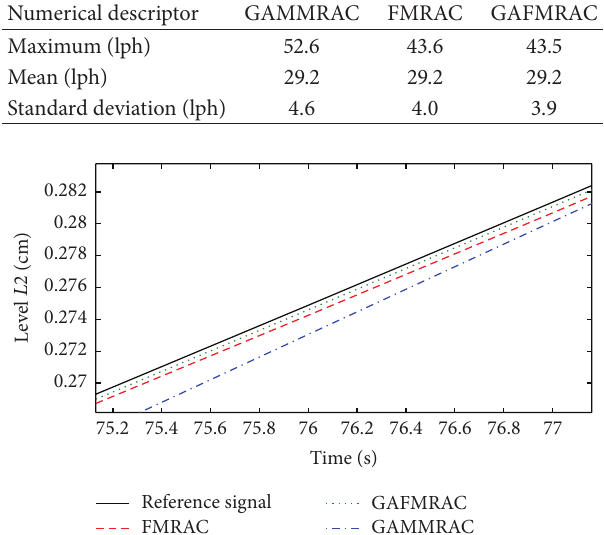
Figure 7: A zoomed in view of the response of the three controllers shown in Figure 6.